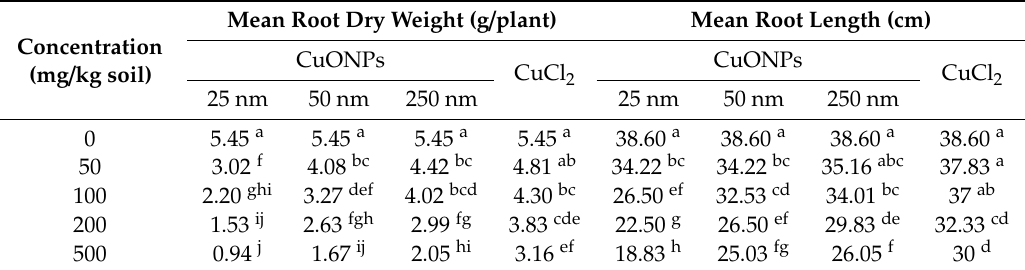
Table 3. E ff ects of CuONPs and CuCl 2 on mean root dry weight and mean root length in soybean. Means with similar letters denote no significant di ff erence between the treatments according to the Fisher’s LSD test ( p ≤ 0.05).